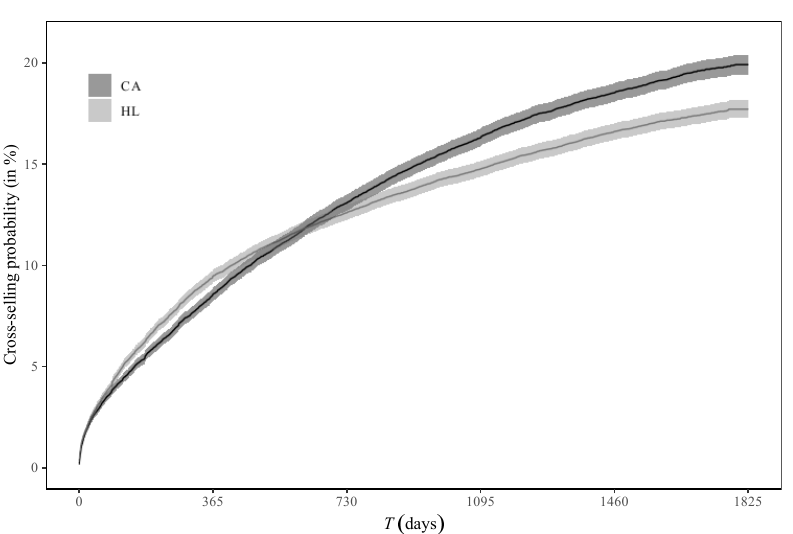
Figure 3. Kaplan–Meier estimates for the cross-selling probability for the CA and HL cohorts. The gray shaded area indicates the 95% confidence interval of the